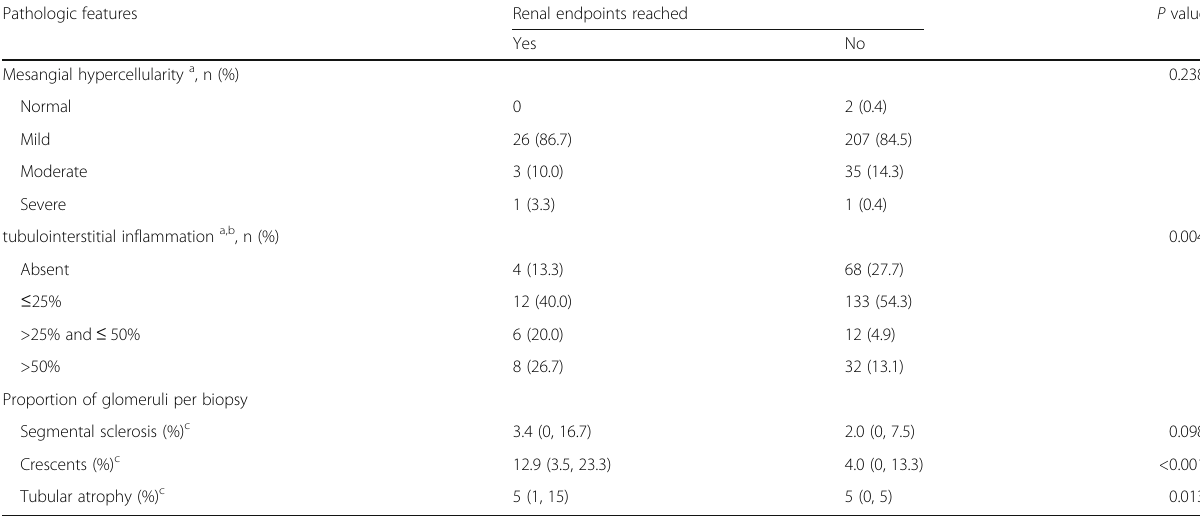
Table 2 Detailed pathologic features for patients with or without renal endpoints Pathologic